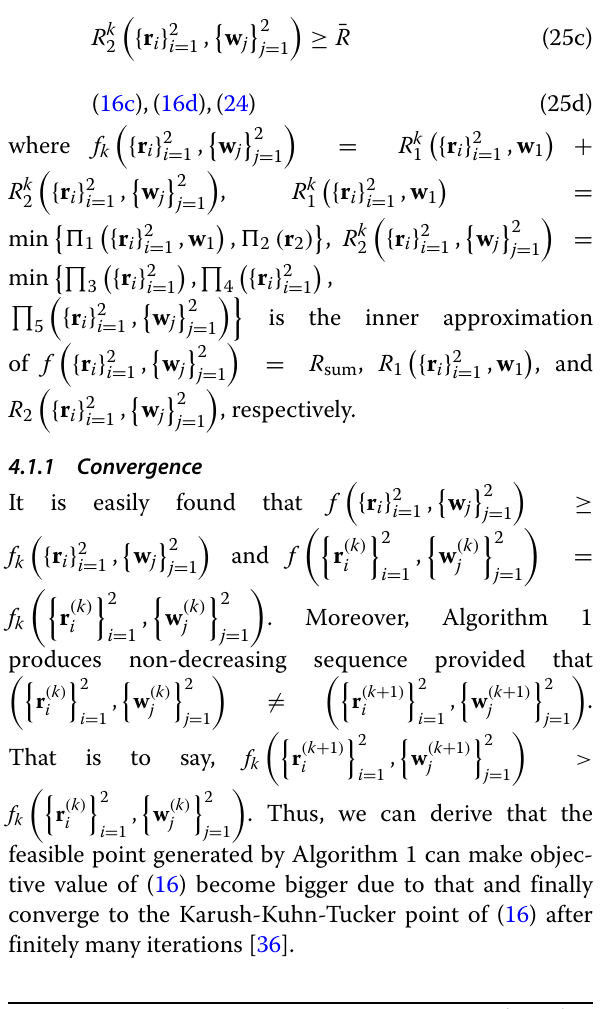
Algorithm 1 Sum Rate Maximization Iteration